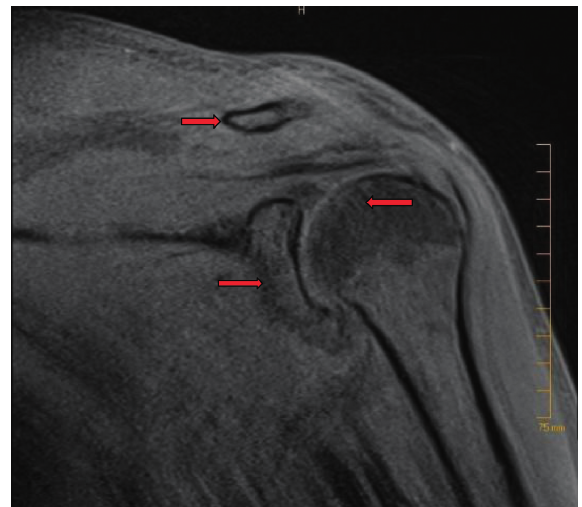
Figure 3: MRI left shoulder revealed acromioclavicular joint sy- novitis with periarticular soft tissue edema consistent with septic arthritis and distal clavicle marrow edema suggestive of osteo- myelitis. A subcentimeter abscess in the subacromial bursa was also